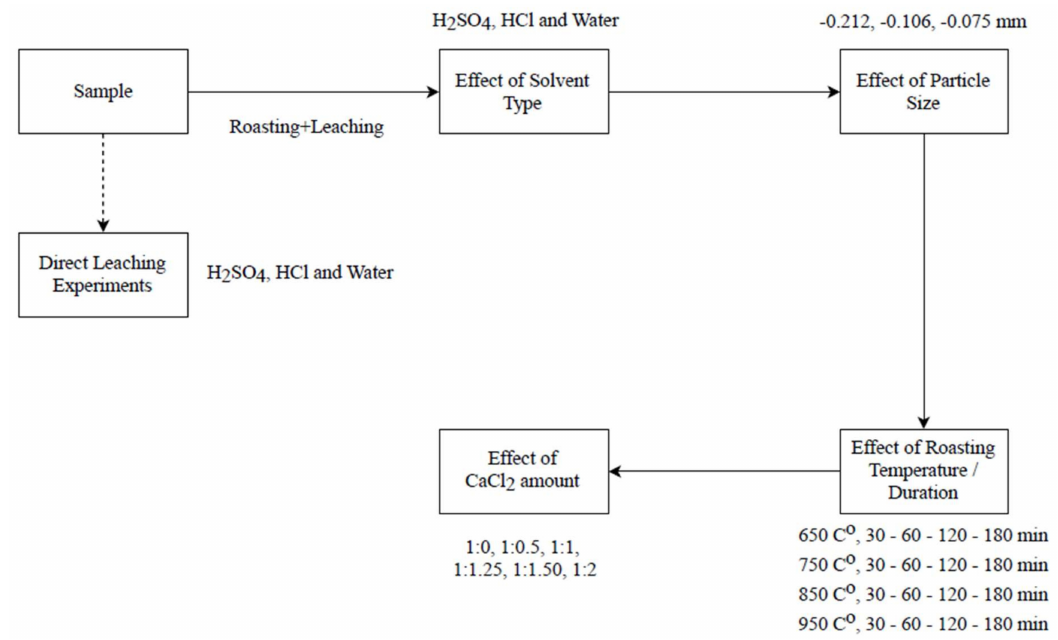
Figure 4. General flowsheet of the experimental studies.